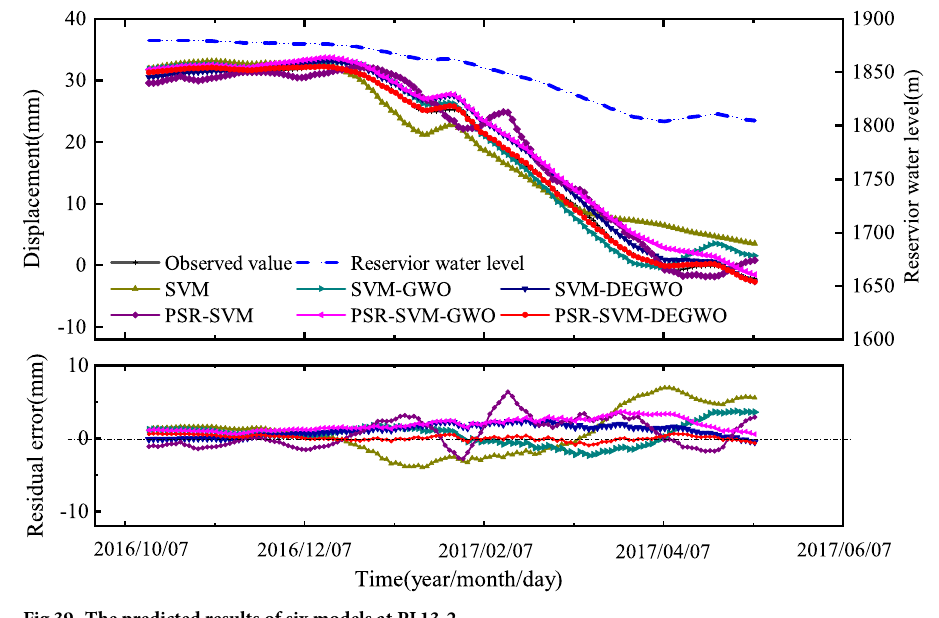
Fig 39. The predicted results of six models at